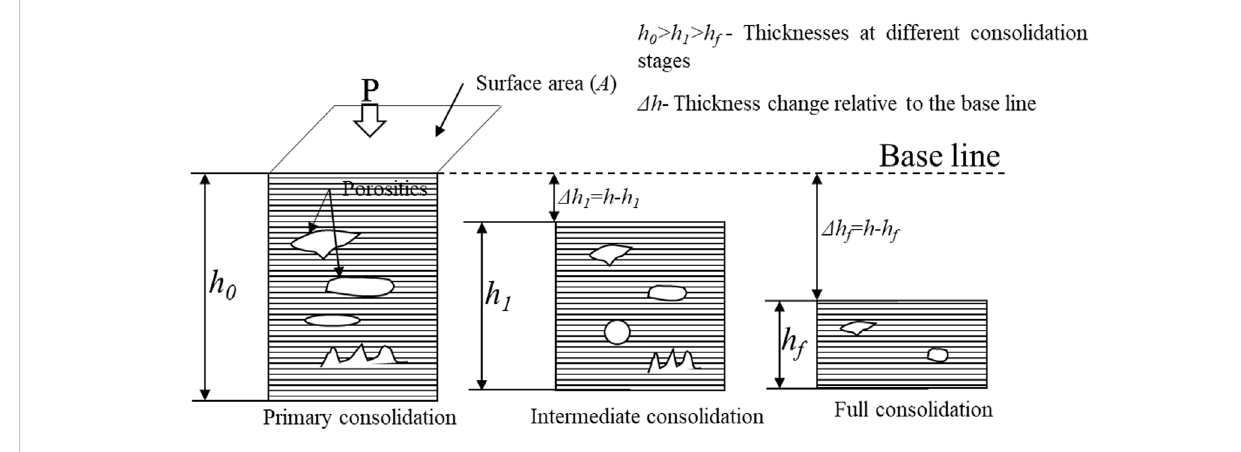
FIGURE 9 the changes in porosity fraction and thicknesses at different stages of consolidation. h f is the fi nal thickness after the full consolidation.